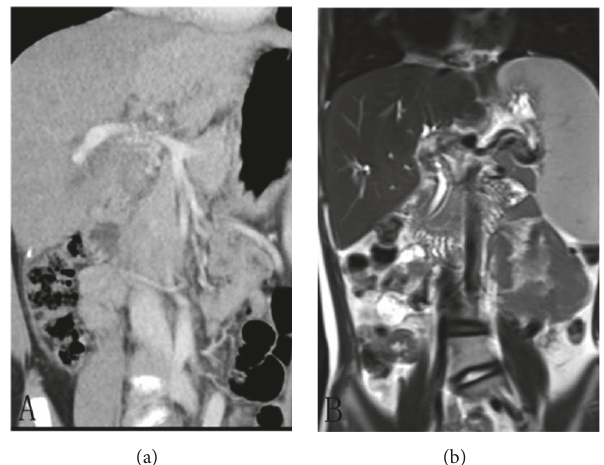
Figure 2: Piggyback liver transplantation was conducted. (a) CT imaging illustrated the reconstructed portal vein was in a satisfactory condition. (b) MR showed the transplanted liver was almost normal in signal 2 years following transplantation.